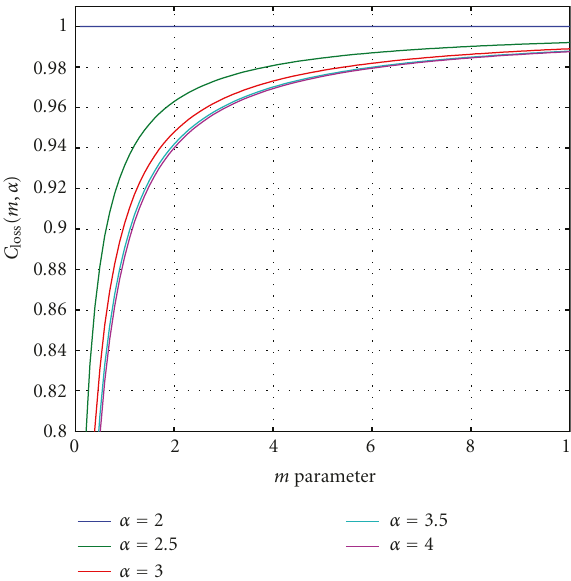
μ γ → 0, ε d ) is referred to as the asymptotic mean node de- f ( r